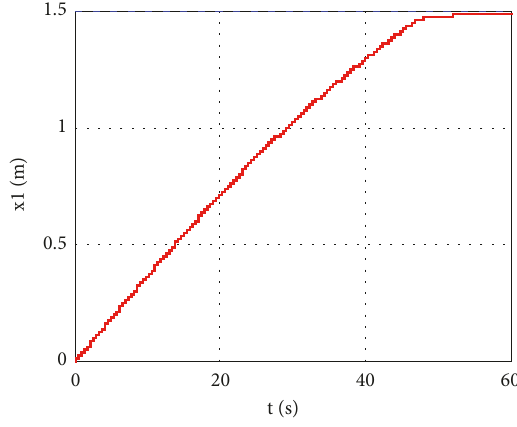
Figure 1: Time dependence of the robot left wheel